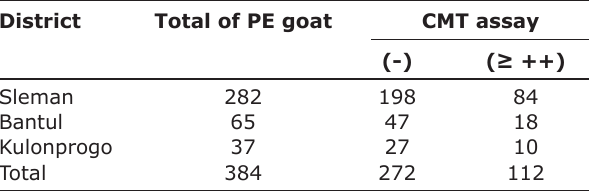
Table-1: Determination of SCM in PE goats based on CMT in